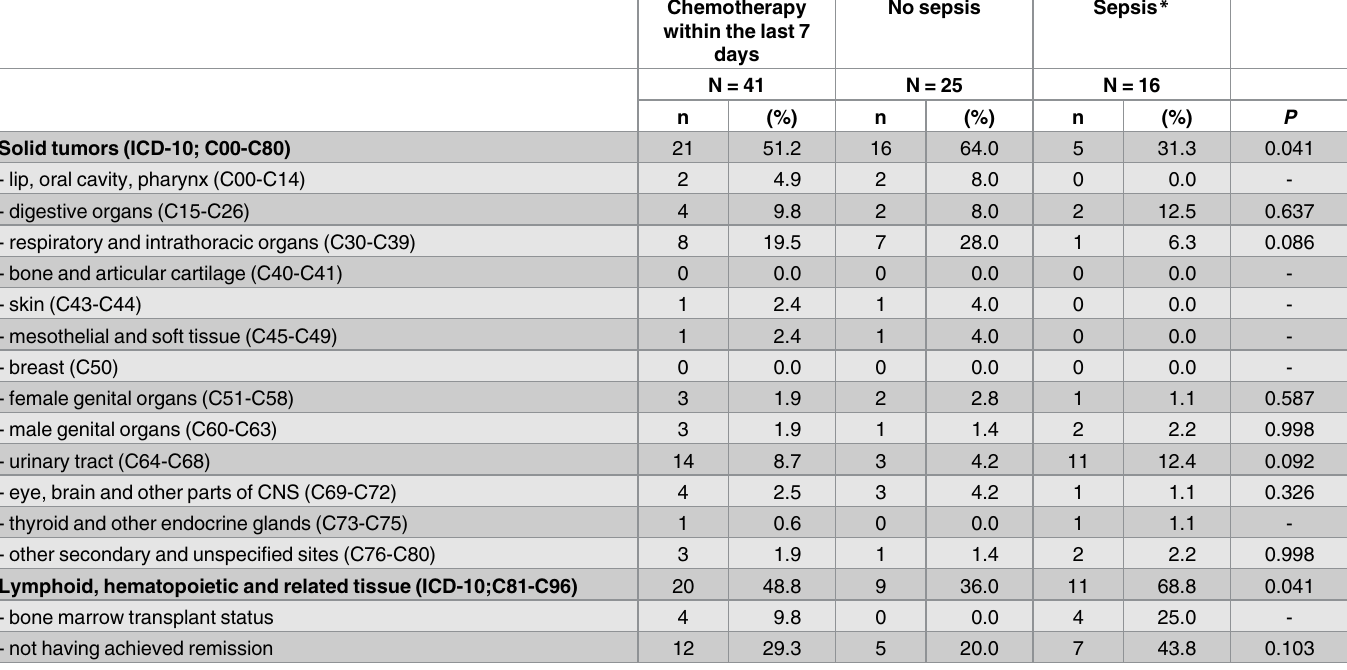
Table 6. Cancer patients with chemotherapy treatment in the last week of life—frequencies of sepsis stratified by tumor